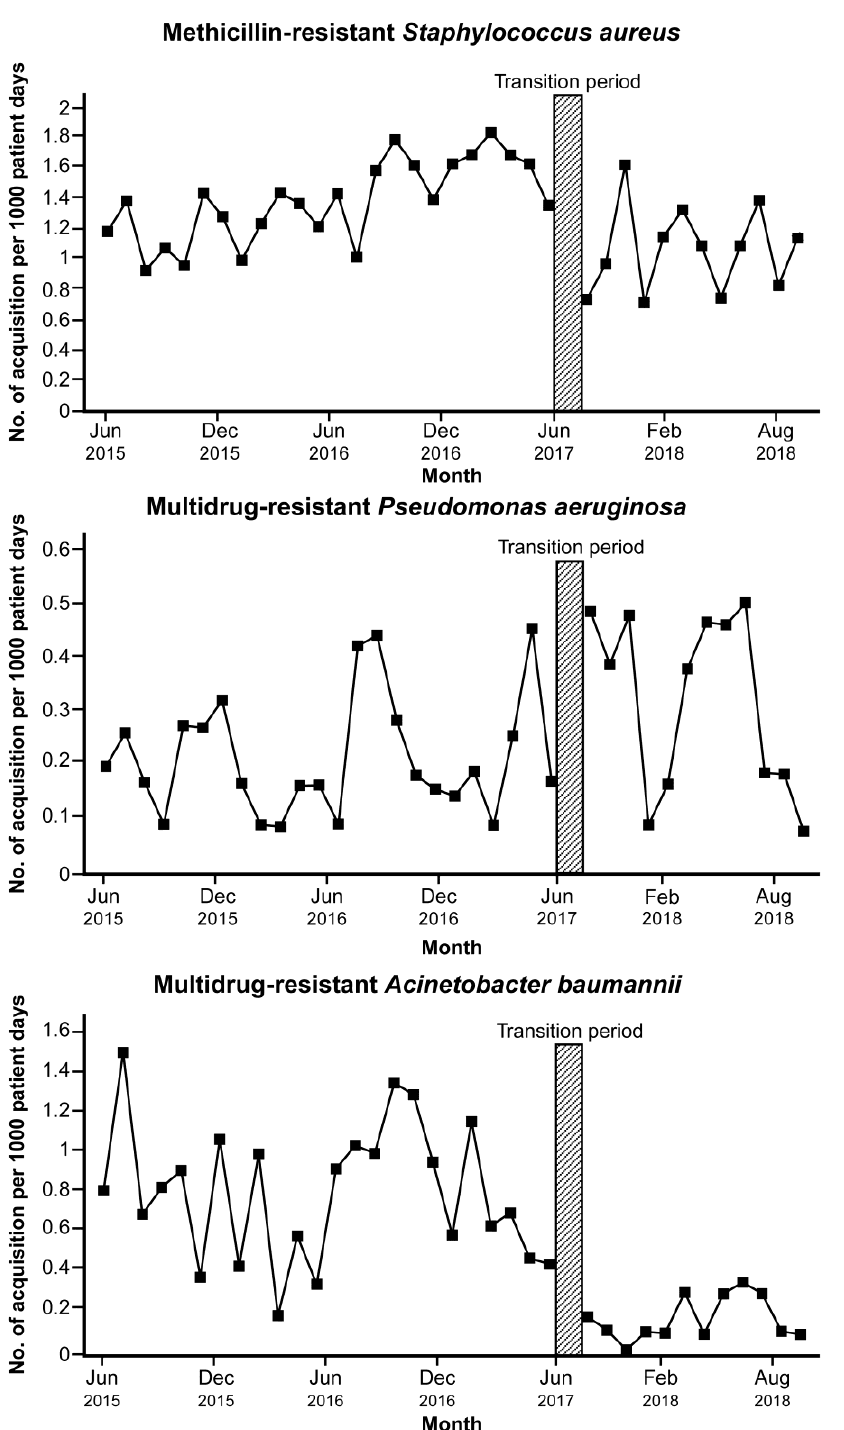
Figure 2. Trends in the incidence of multidrug-resistant organisms acquisition among patients in the hospital before and after implementation of the antimicrobial stewardship program led by an infectious disease specialist. Transition period is a three-month lag allowing for the intervention process to stabilize.